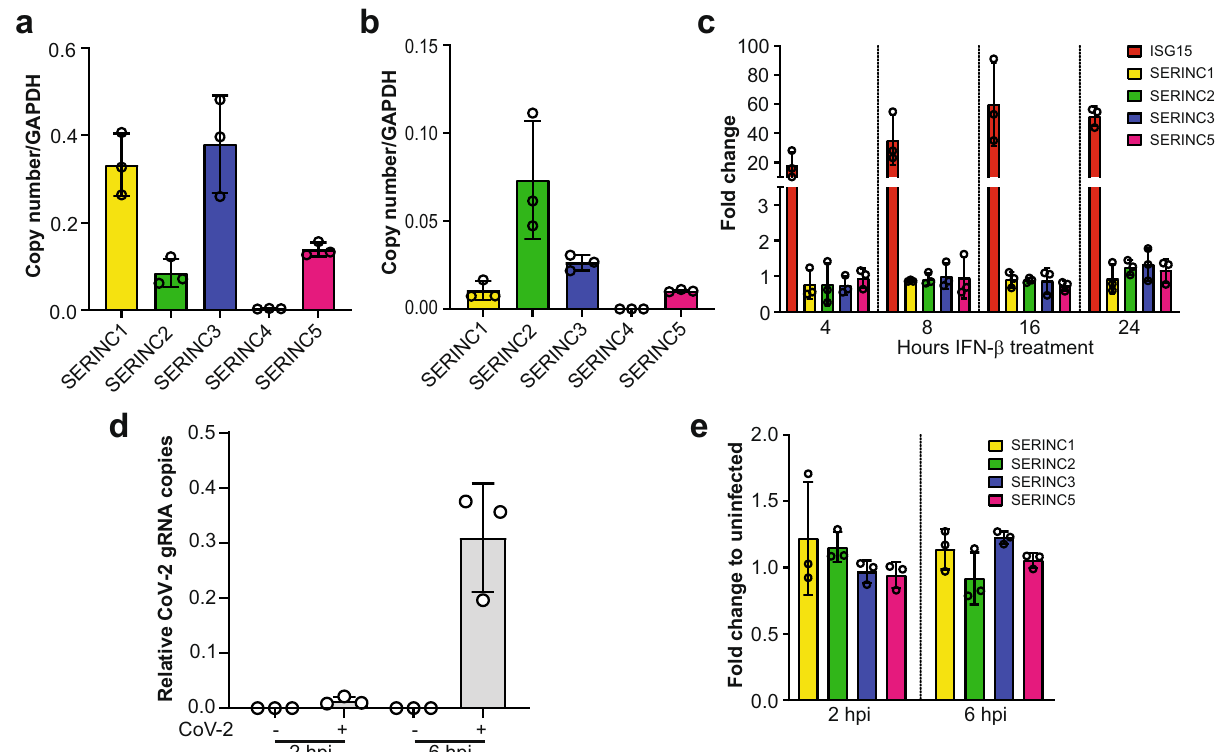
Fig. 1 SERINC genes are expressed in pneumocytes and their expression levels are unaffected by SARS-CoV-2 infection and type I IFN. a SERINC1, 2, 3, 4, and 5 RNA copy number relative to GAPDH in total lung RNA. Graphs represent mean ± SD from three independent donors. b SERINC1, 2, 3, 4, and 5 RNA copy number relative to GAPDH in Calu-3 cells. c Fold expression change of SERINC1, 2, 3, 5, and ISG15 transcripts relative to mock, normalized to GAPDH in Calu-3 cells treated with IFN β (500 U/ml) for 4 h, 8 h, 16 h or 24 h. Mock indicates mock-treated (PBS). d SARS CoV-2 gRNA copies relative to GAPDH from Calu-3 cells infected with SARS-CoV-2 for 2 h or 6 h e SERINC1, 2, 3, and 5 transcripts fold expression from d relative to uninfected Calu-3 cells and normalized to GAPDH. All graphs represent mean ± SD from 3 independent experiments. (hours post infection, hpi; SARS-CoV-2,